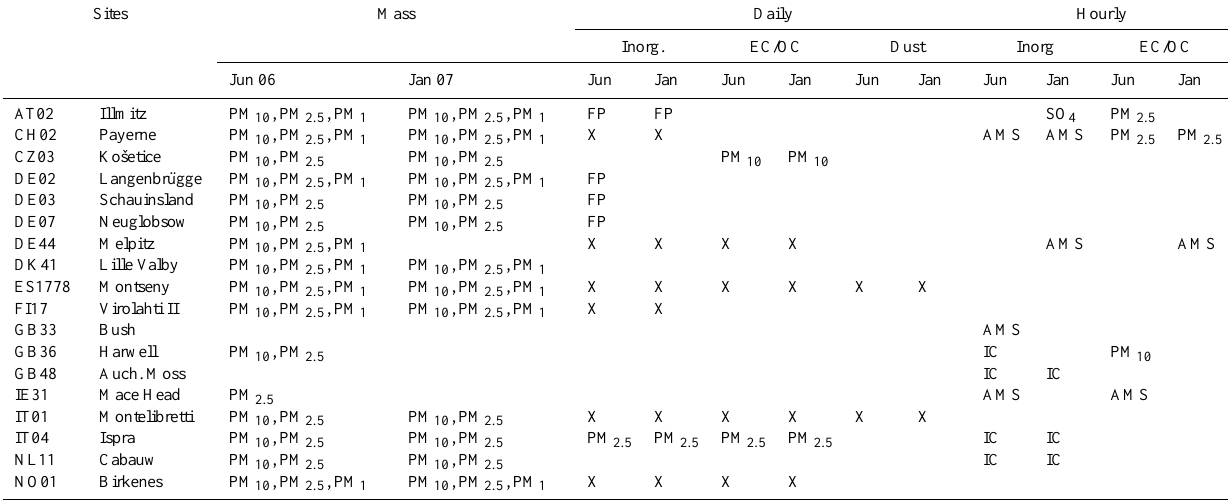
Table 1. Measurements being conducted during the EMEP intensive periods in June 2006 and January 2007. Sites Mass Daily Inorg.